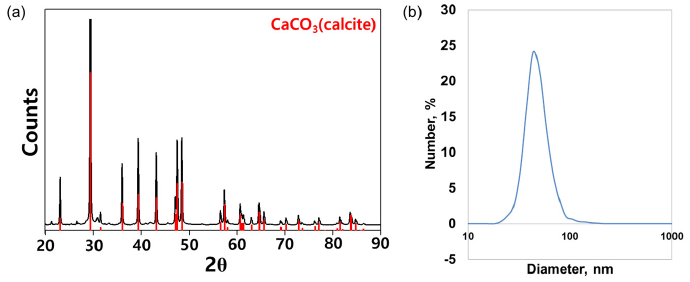
Figure 6. XRD and DLS analyses of CaMg(CO 3 ) 2 . Notes: ( a ) XRD pattern of the purified CaMg(CO 3 ) 2 . The Braggs reflections were identified in the XRD. ( b ) The distribution of hydrodynamic diameter of namic diameter of CaMg(CO 3 ) 2 measured by DLS. Abbreviations: XRD, X-ray diffraction; DLS, CaMg(CO 3 ) 2 measured by DLS. Abbreviations: XRD, X-ray diffraction; DLS, dynamic light scattering; dynamic light scattering; CaMg(CO 3 ) 2 , dolomite nanoparticles. CaMg(CO 3 ) 2 , dolomite